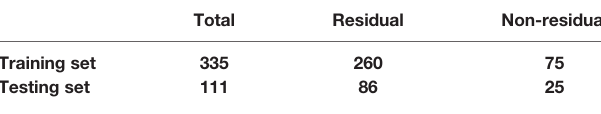
TABLE 3 | Number of images in the training set and test